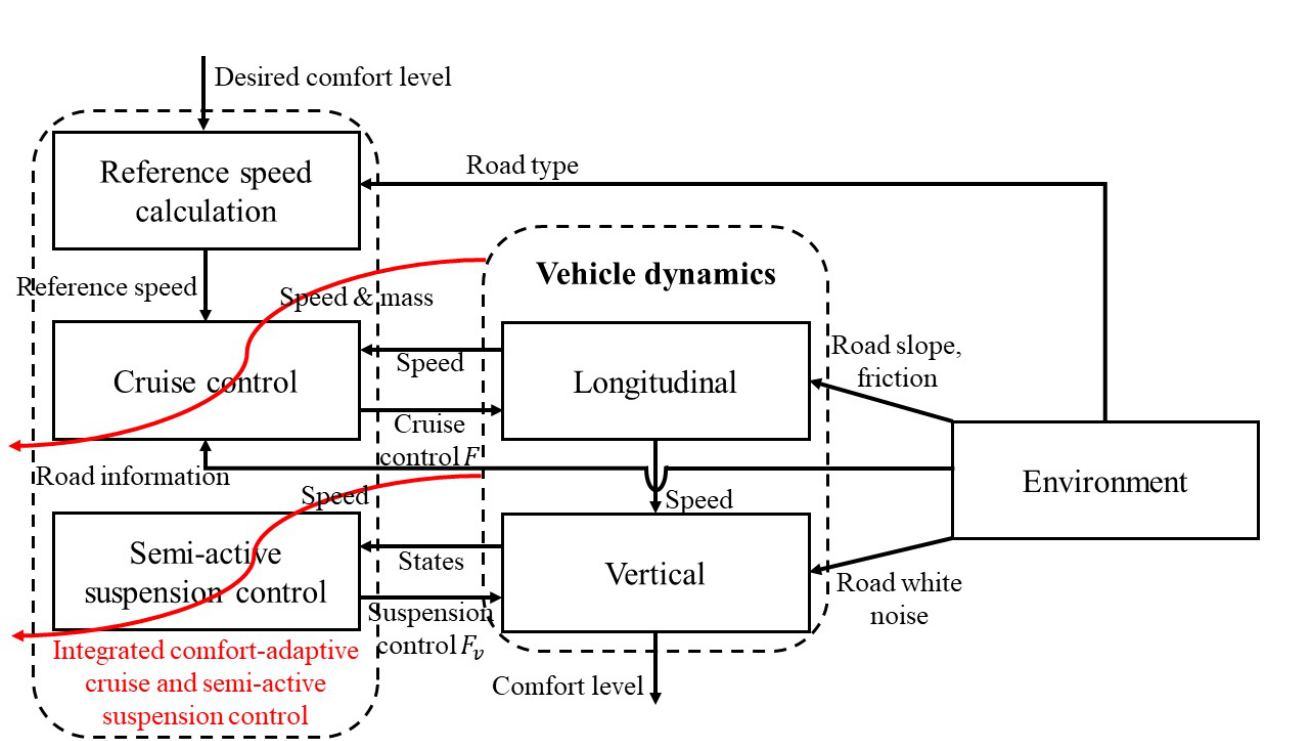
Figure 5. Integrated cruise—suspension linear parameter-varying (LPV) control for